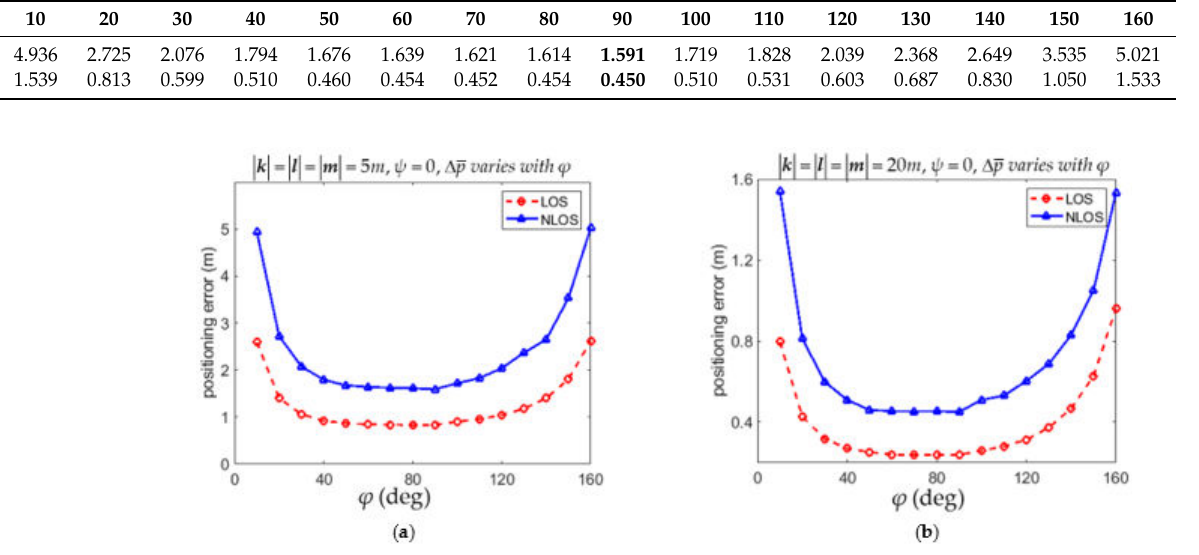
Figure 10. Variation of 3D RMSPE ∆ p with angles ϕ for the LOS and NLOS conditions. ( a ) The